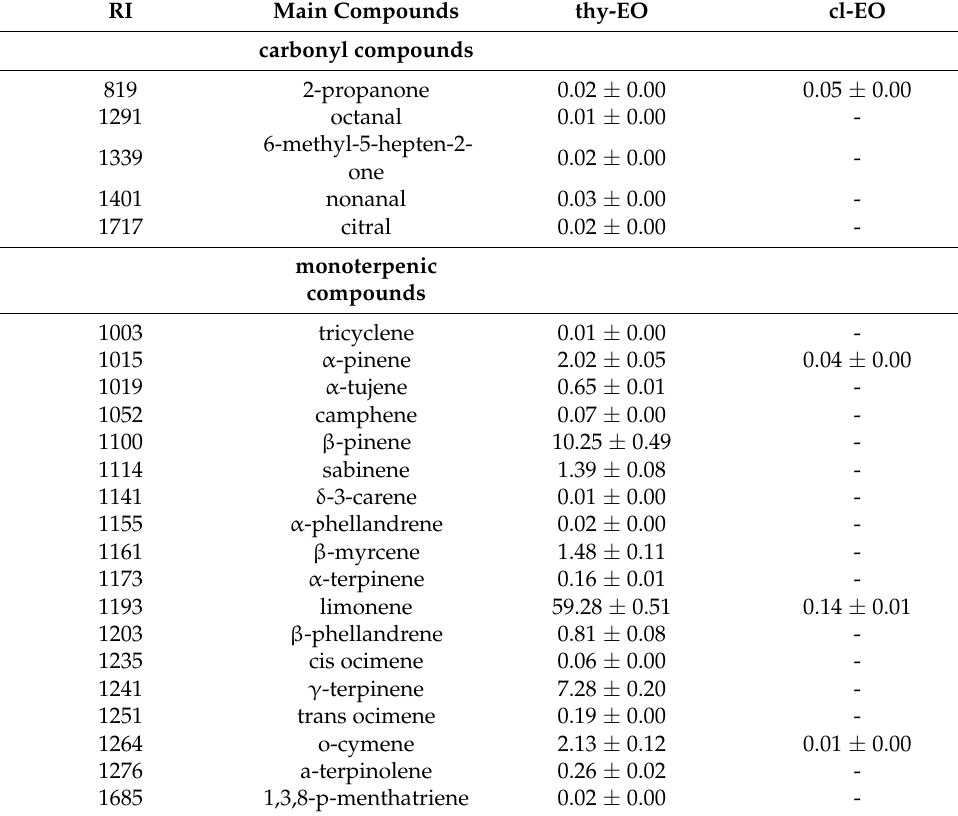
Table 1. Chemical composition of essential oils (EOs) extracted from cloves and thyme.